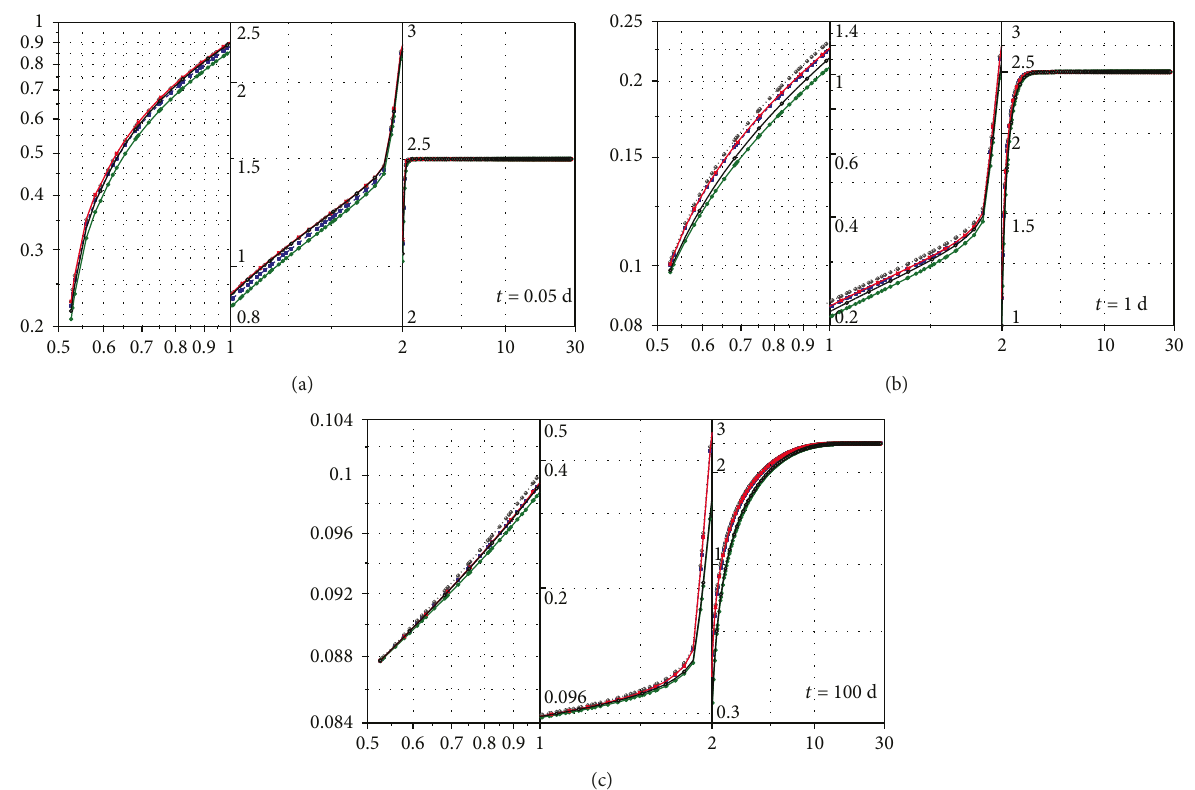
Figure 11: Impacts of the non-Darcy e ff ect, gas-coal interaction e ff ect, and Klinkenberg e ff ect on gas pressure.